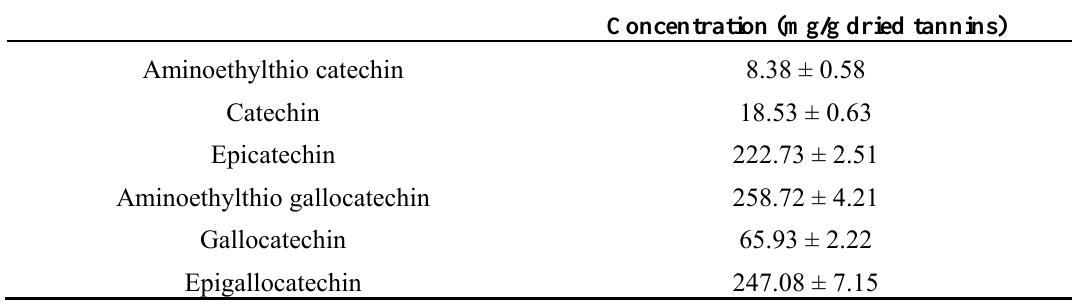
Table 1. Concentration of terminal and extension units of condensed tannins of L . glaber leaves determined by HPLC following thiolysis